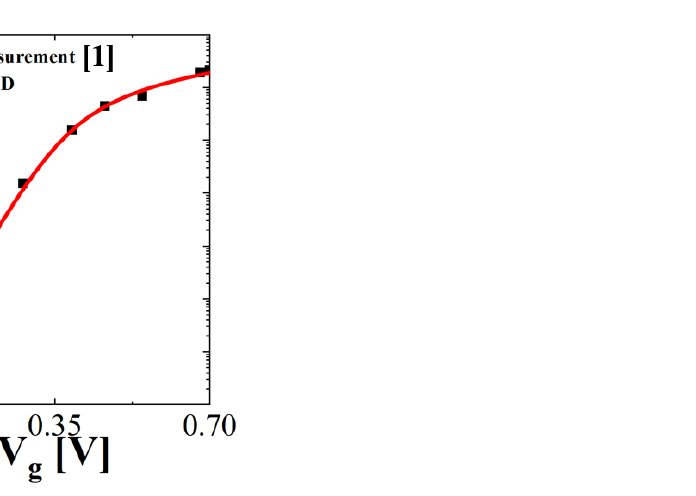
Figure 1. ( a ) 3D device structure with doping profile. Positive (+) and negative ( − ) signs in the concentration legend represent n − and p − type doping, respectively. ( b ) Drain current ( I d ) versus gate voltage ( V g ) characteristics with calibration of experimental reference [1].